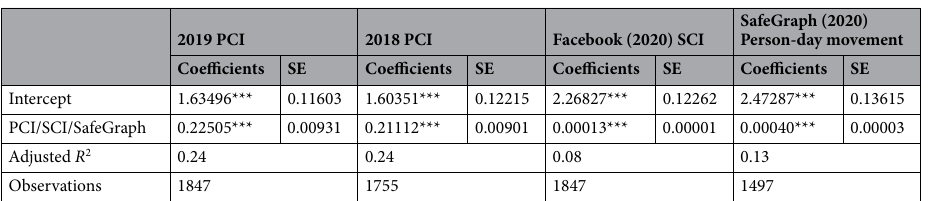
Table 2. Regression result using COVID-19 infection rate as the dependent variable, and PCI, SCI, or SafeGraph as the predictor variable. * p < 0.1, ** p < 0.05, *** p < 0.01.